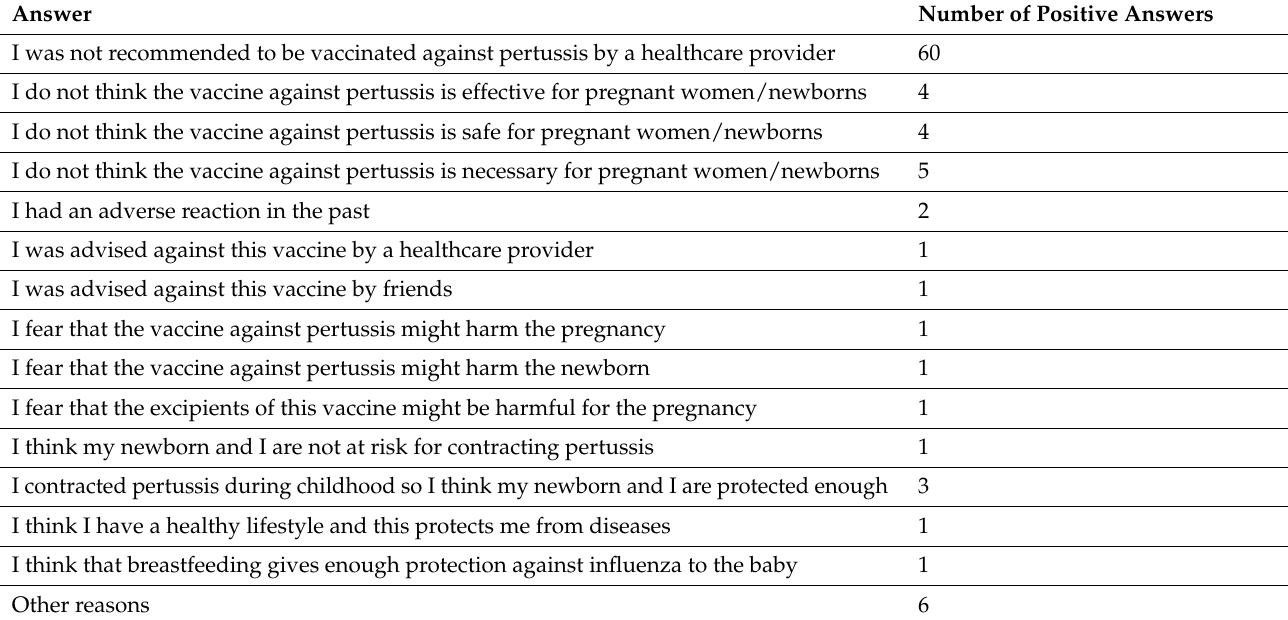
Table 7. Main reason not to be vaccinated against pertussis—92 patients who refused both Tdap and flu shot. Answer Number of Positive